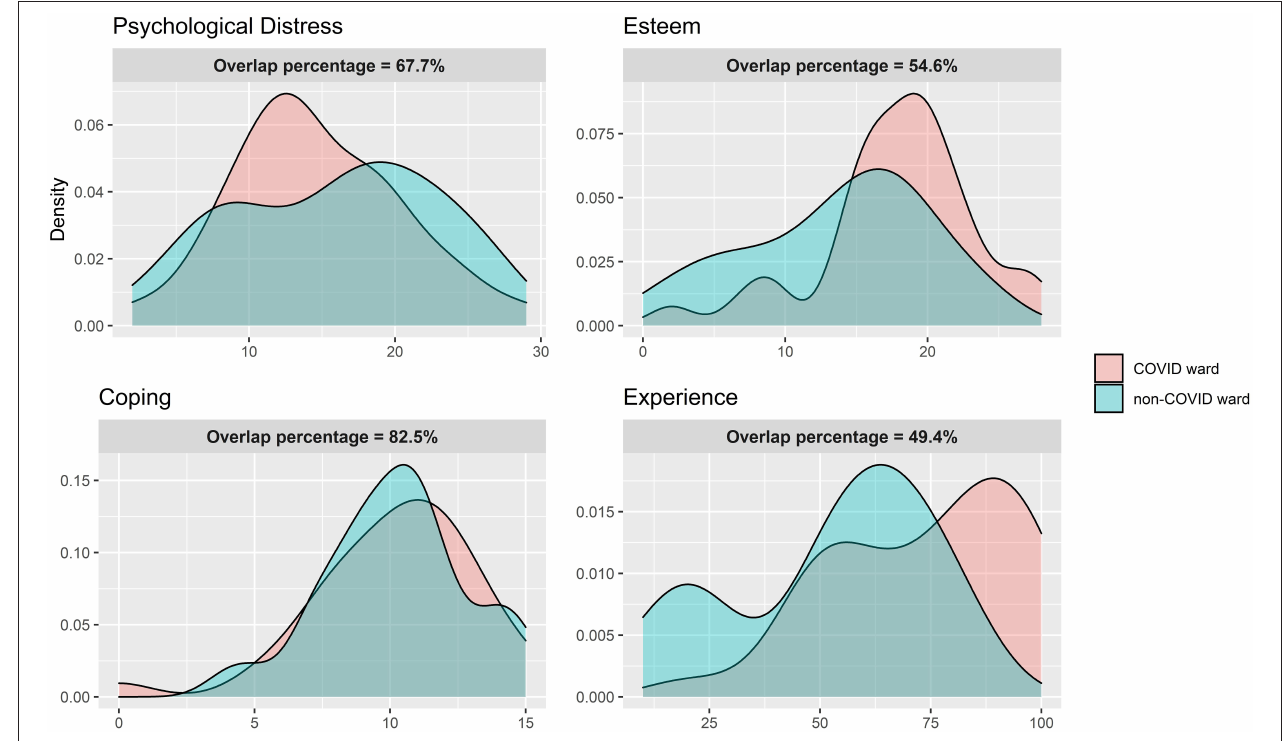
FIGURE 2 | Study 2. Distributions overlapping between HC from the COVID-19 ward and HC from the non-COVID-19 ward.